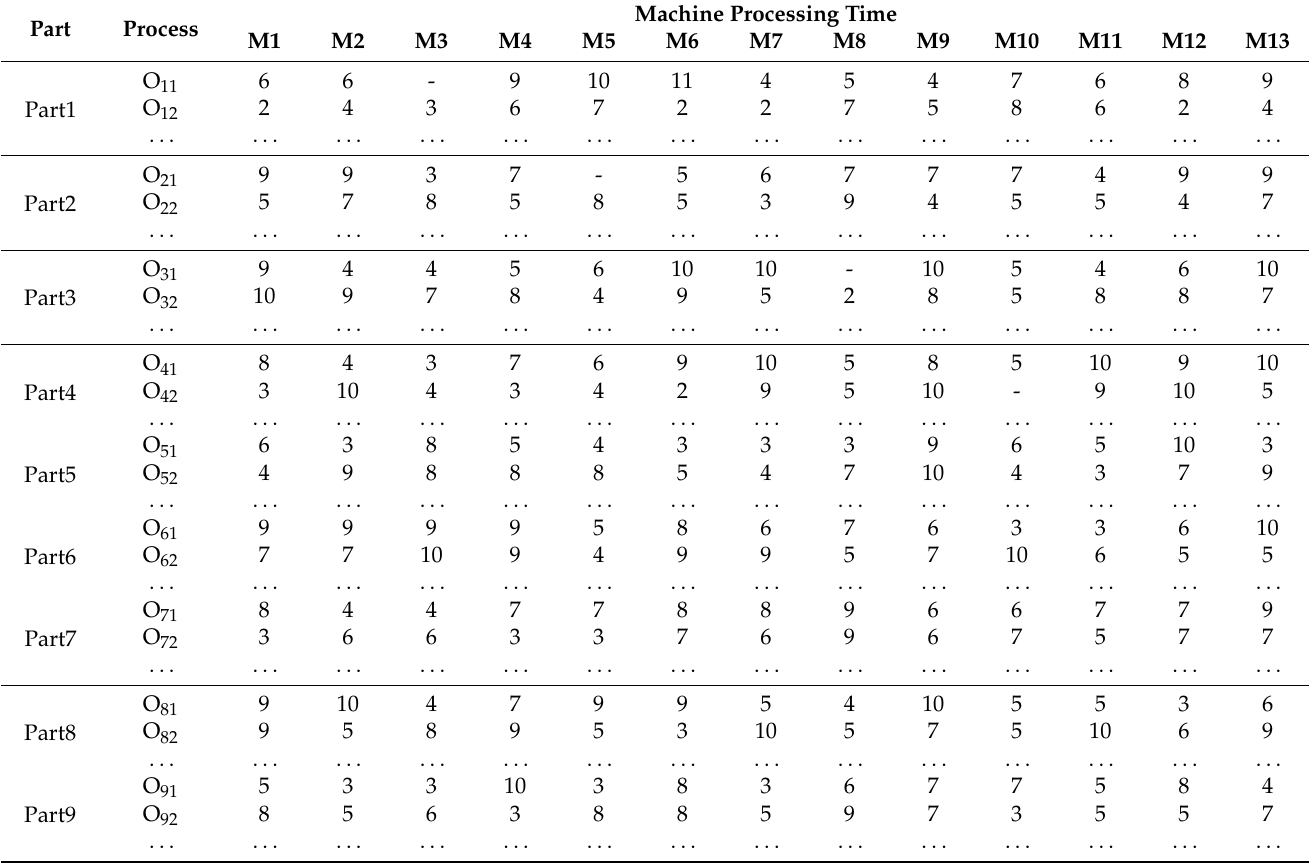
Table 5. 9 × 13 problem example.